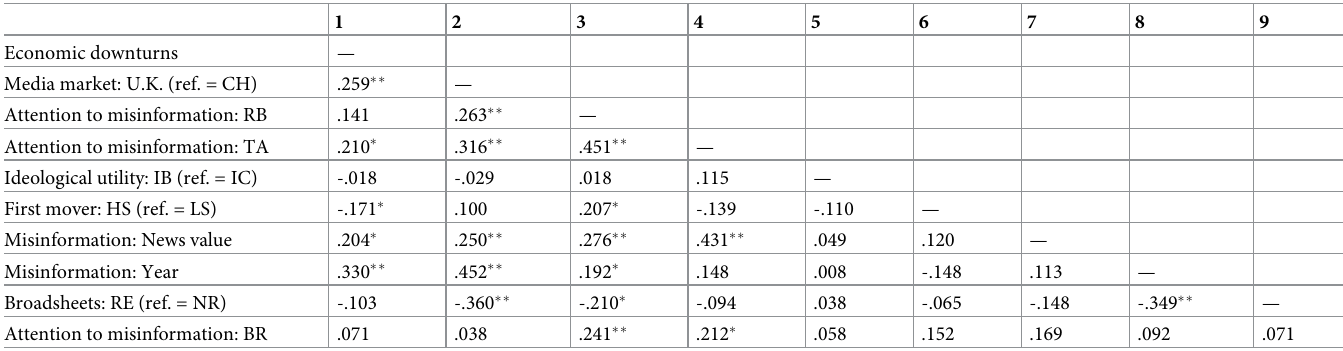
Table 4. Bivariate correlations (business